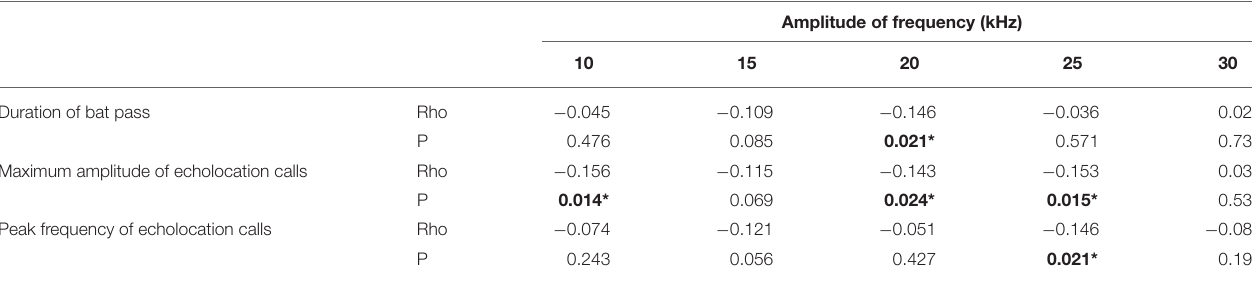
TABLE 1 | The relationship between acoustic characteristics of bat echolocation calls and the change in amplitude of ambient sound by frequency (Spearman rank correlation coefficients and p